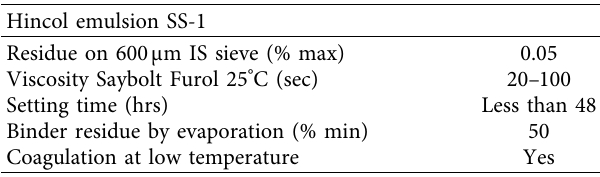
Table 2: Properties of the bitumen emulsion [22].